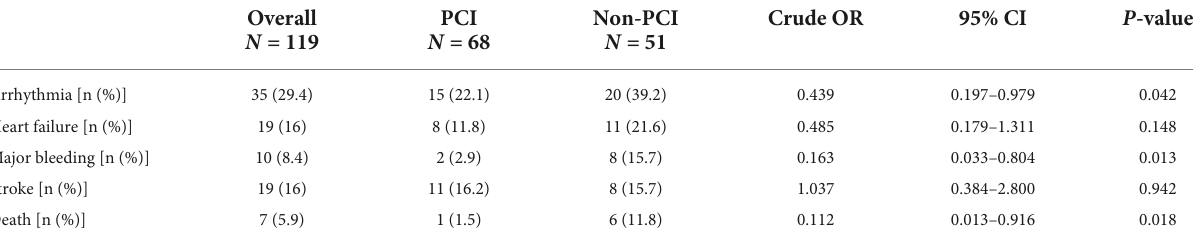
TABLE 2 In-hospital outcomes among two groups.